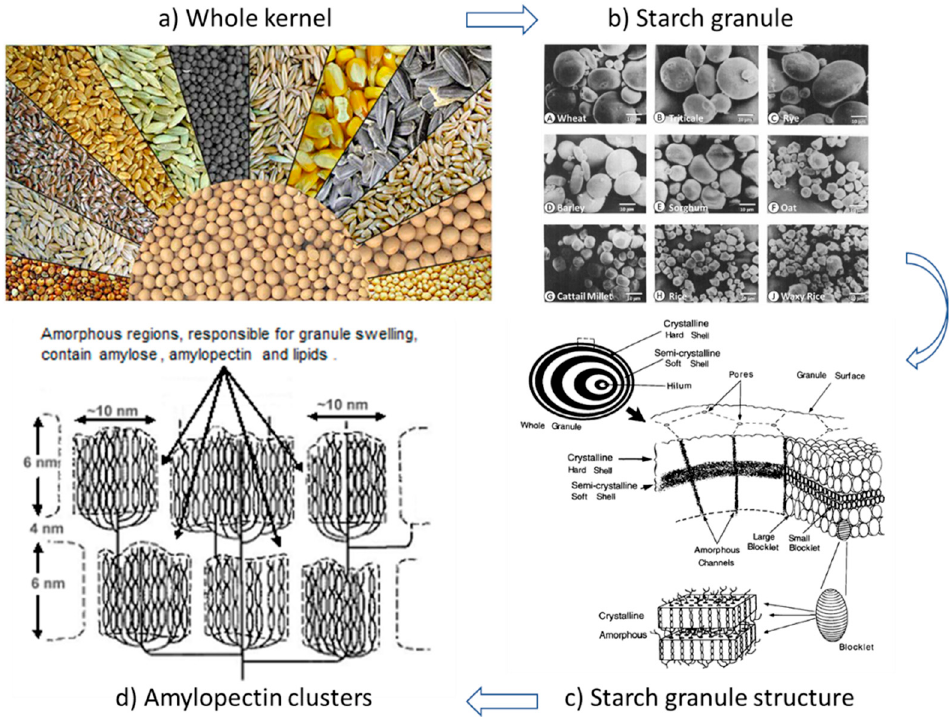
Figure 2. Hierarchy of shape and structure from ( a ) the kernel [87] to ( b ), the starch granule [84] to ( c ), layering within a granule and the alternate layering substructure [85] to ( d ), the highly branched and long chain polymers [85]. Images and permissions obtained from cited references.